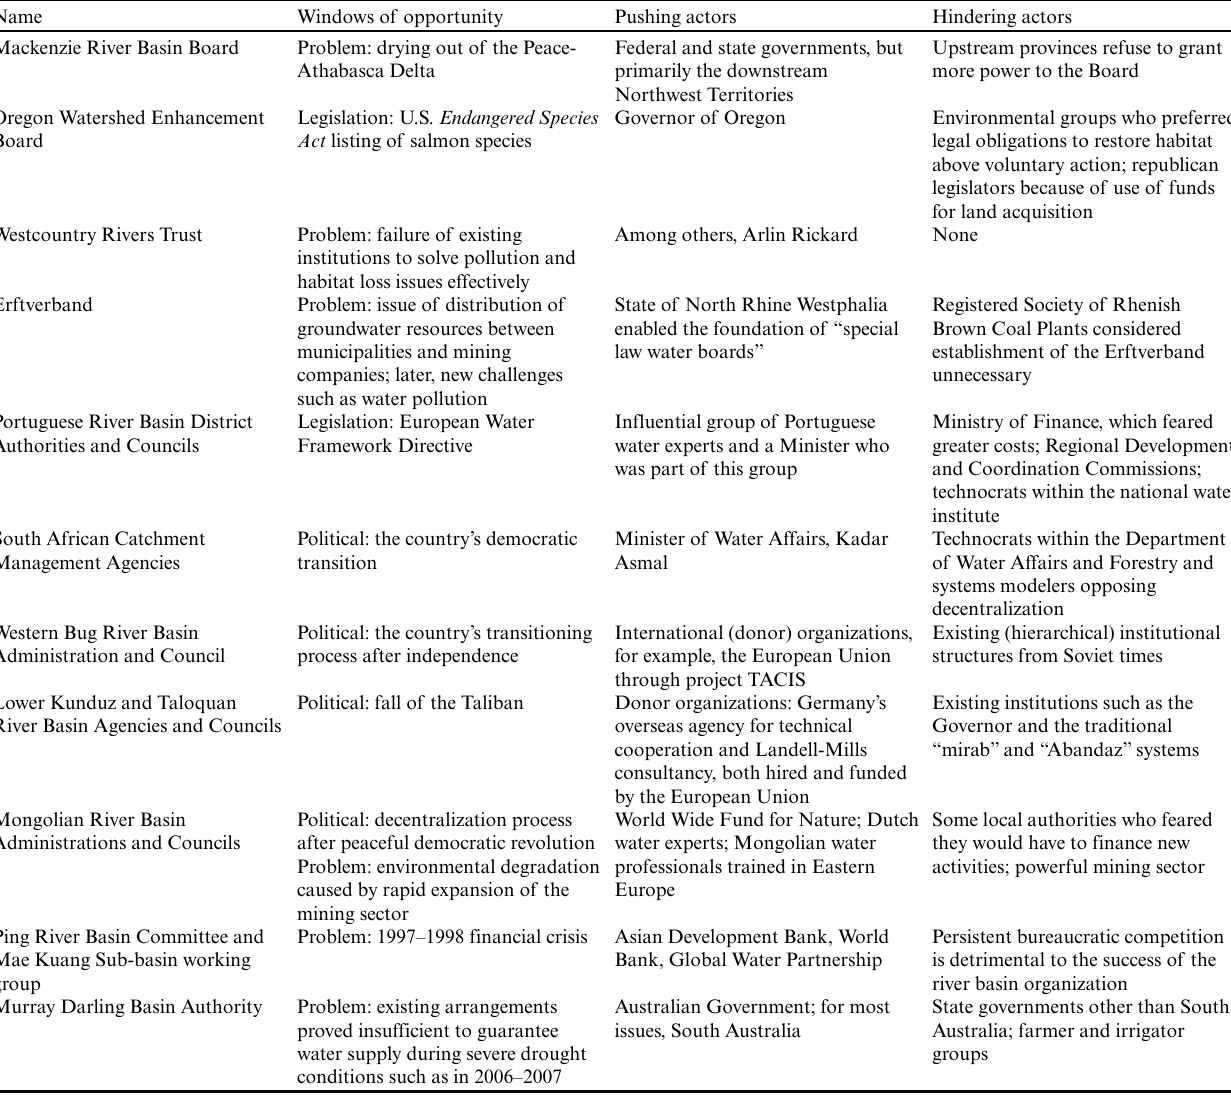
Table 3. Windows of opportunity and actors pushing or hindering the founding and reform of river basin